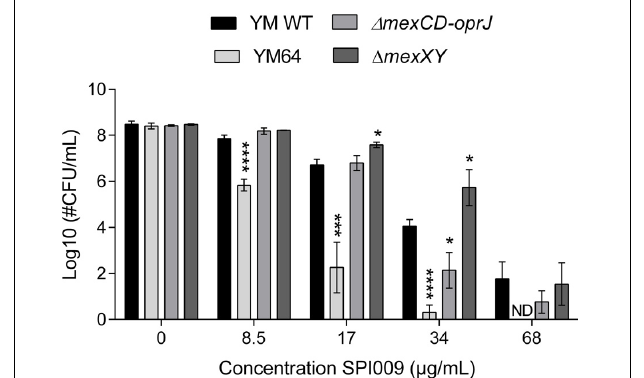
FIGURE 8 | Activity of SPI009 in efflux mutants. P. aeruginosa efflux mutants YM64, (cid:49) mexCD-oprJ and (cid:49) mexXY , together with their WT strain YM, were treated for 5 h with increasing concentrations of SPI009. Significant differences in sensitivity toward SPI009 between the WT and different mutants were detected using multiple t -tests ( α = 0.05) with Holm–Sidak correction for multiple comparisons and represented by ∗ P < 0.05; ∗∗∗ P ≤ 0.001; and ∗∗∗∗ P < 0.0001. Values represent the average of at least three independent repeats with error bars depicting SEM values. ND, not detected.